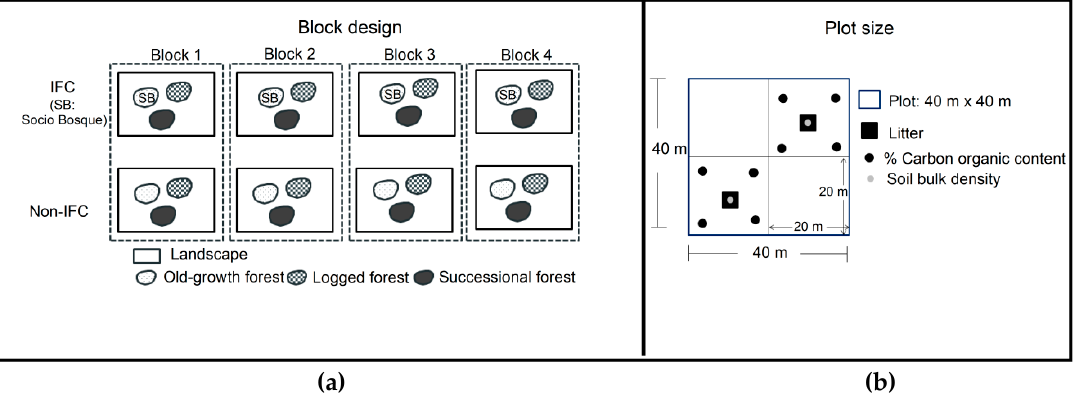
Figure 2. ( a ) Randomized block design for the selection of the study areas. ( b ) Plot design implemented to assess information on carbon stocks, total timber volume and species richness.